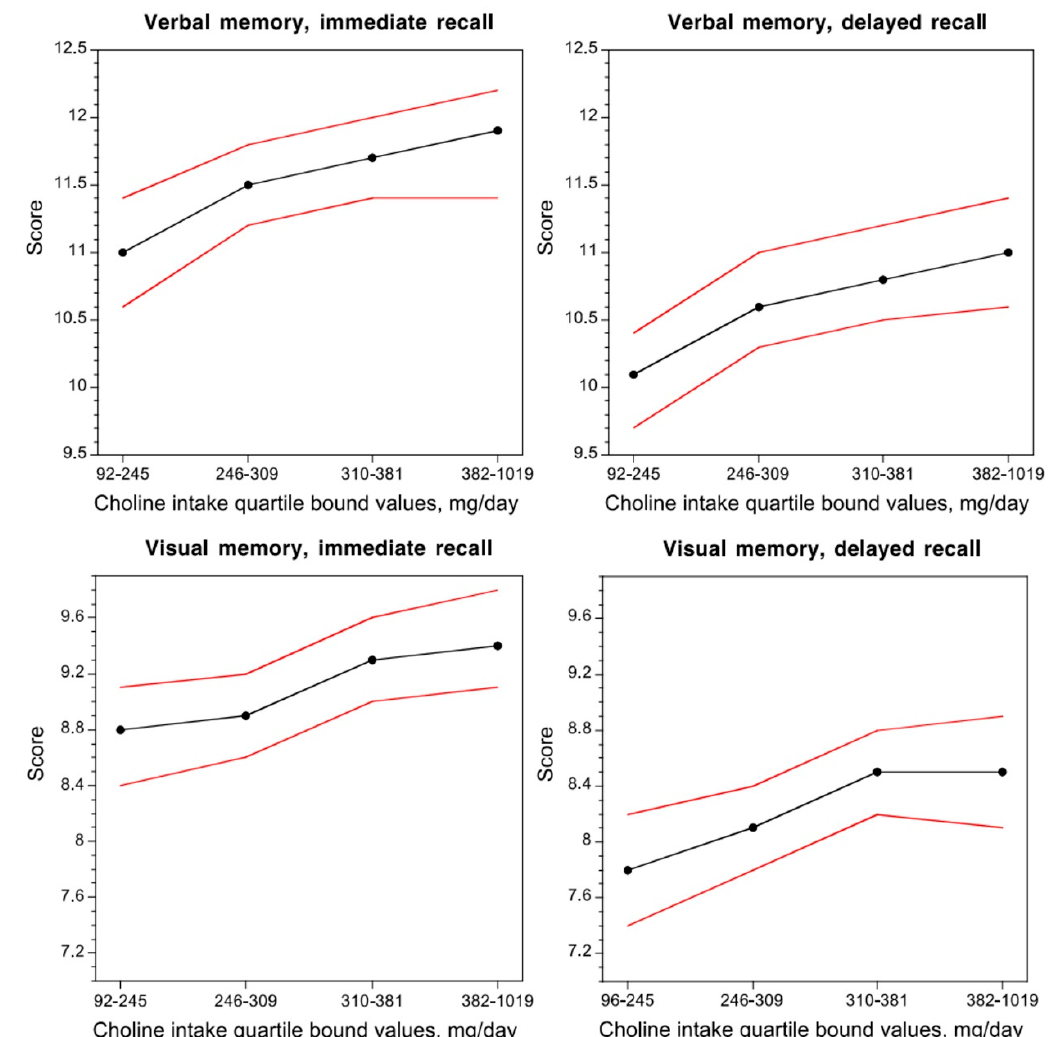
Figure 2. Dose–response relationship between the average daily choline intake and verbal and visual memory performance in non-demented adults. Black lines indicate the mean score and red lines indicate 95% confidence interval. Figure reproduced from [44] .